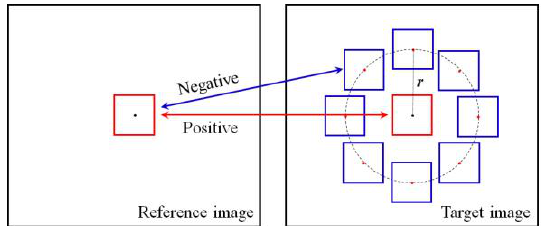
Figure 6. Negative sample generation by considering the distance between the centre points of matching and non- matching patches.